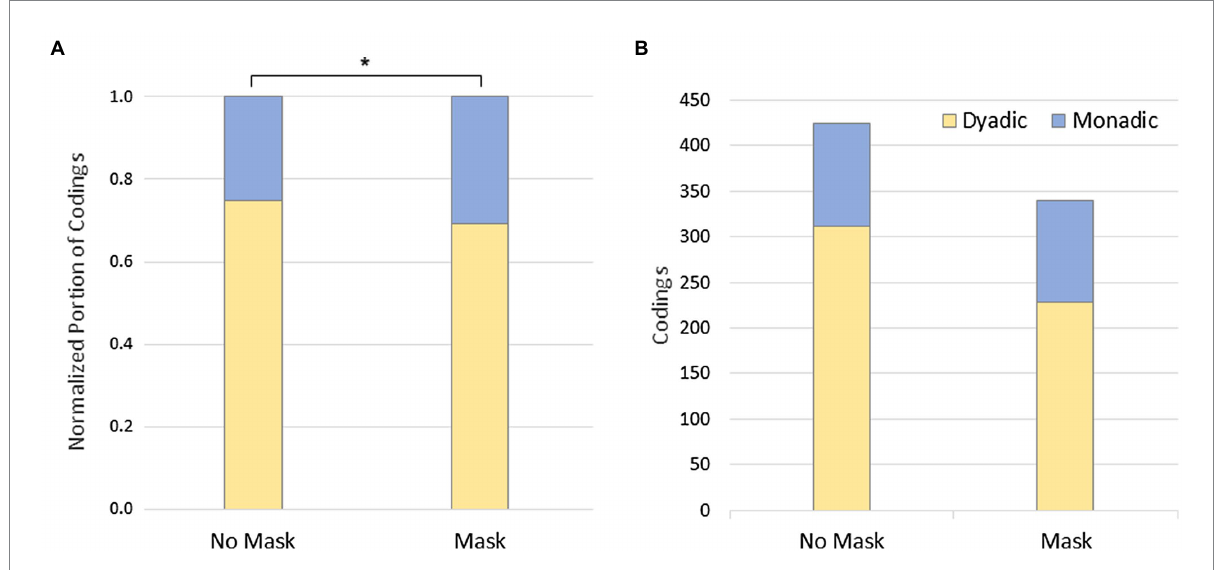
FIGURE 3 Level 1: Dyadic/monadic experience. (A) Relative rating, * p = 0.048; (B) absolute